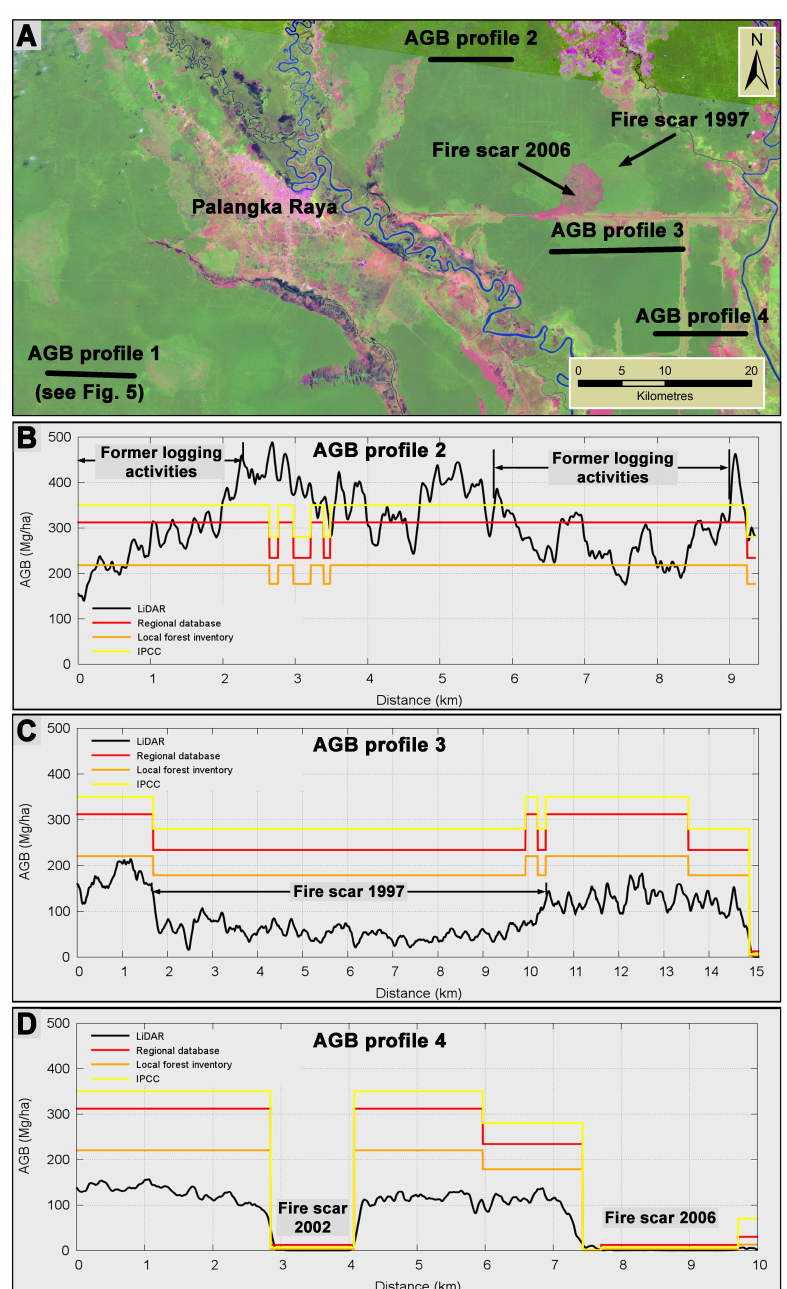
Fig. 6. Examples of different AGB profiles where LiDAR-based AGB estimates are compared to the AGB values attributed to the land cover classes from the Landsat classification on peatlands within the LiDAR stripes. Three different sources for AGB values were attributed to the land cover classes: site-specific field inventory data (field plots, orange), regional literature estimates (regional database, yellow), and IPCC default values (IPCC, red). AGB profile 1 is described in more detail in Fig. 3. (A) Location of the AGB profiles within the study area superimposed on Landsat imagery from the year 2007. (B) AGB profile 2 (9.5km long) covers two areas of former logging activities (0.0–2.2km and 5.9–9.0km) within a peat swamp forest. Here the AGB variability within the forest and the lower AGB values in the logging areas is visible in the LiDAR estimates but not in the Landsat-based estimates. (C) AGB profile 3 (15.2km long) within a peat swamp forest covering a fire scar from the year 1997 (1.8–10.4km). The Landsat-based AGB estimates are much higher than the LiDAR estimates. Also the LiDAR AGB estimates give an idea on the AGB variability which the Landsat-based estimates are not able to give. (D) AGB profile 4 (10km long) within a peat swamp forest covering one fire scar from the year 2002 (2.9–4.1km) and another fire scar from the year 2006 (7.5–10.0km). Here also the Landsat-based AGB estimates for peat swamp forest are much higher than the LiDAR